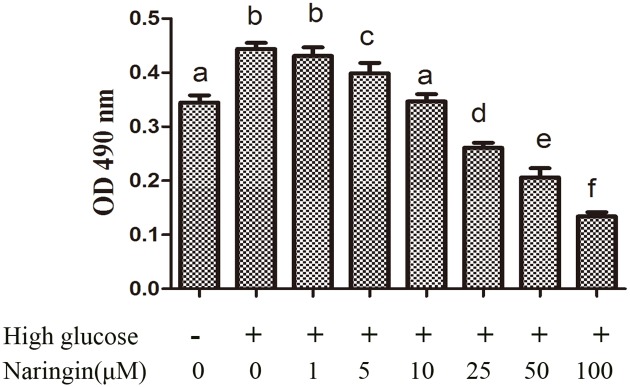
Naringin inhibited high glucose-induced proliferation in HBZY-1 cells.The proliferation of HBZY-1 cells was determined by MTT assay. Data were expressed as means ± SD, n = 5.a-f Means with different superscripts are significantly different (P< 0.05).